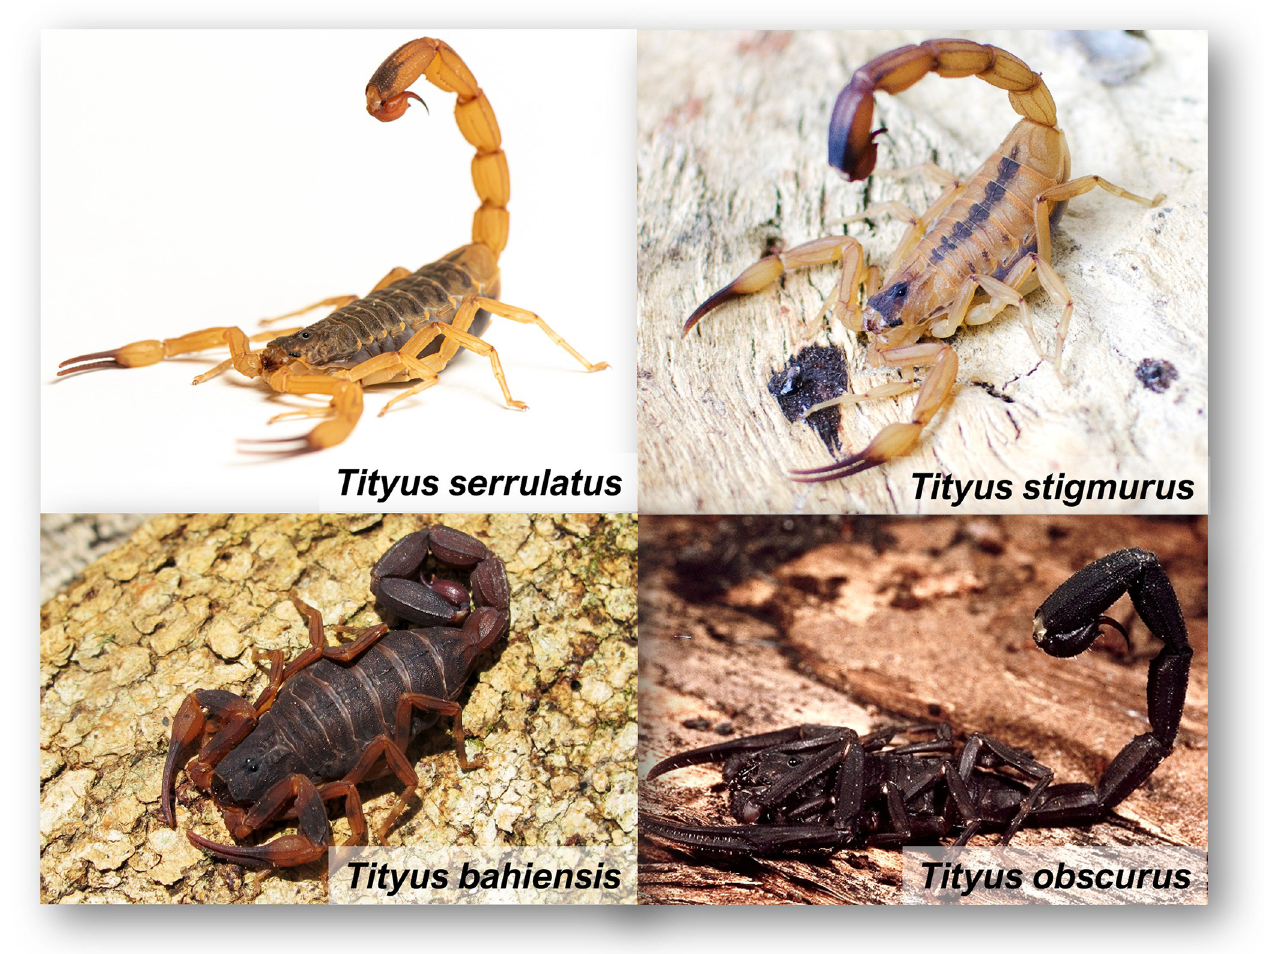
Fig 5. Main scorpion species of medical importance in Brazil. Image credits: Tityus serrulatus, Tityus stigmurus (Leonardo Noronha), Tityus bahiensis, and Tityus obscurus (Roberto Murta), provided under a CC BY 4.0 license.